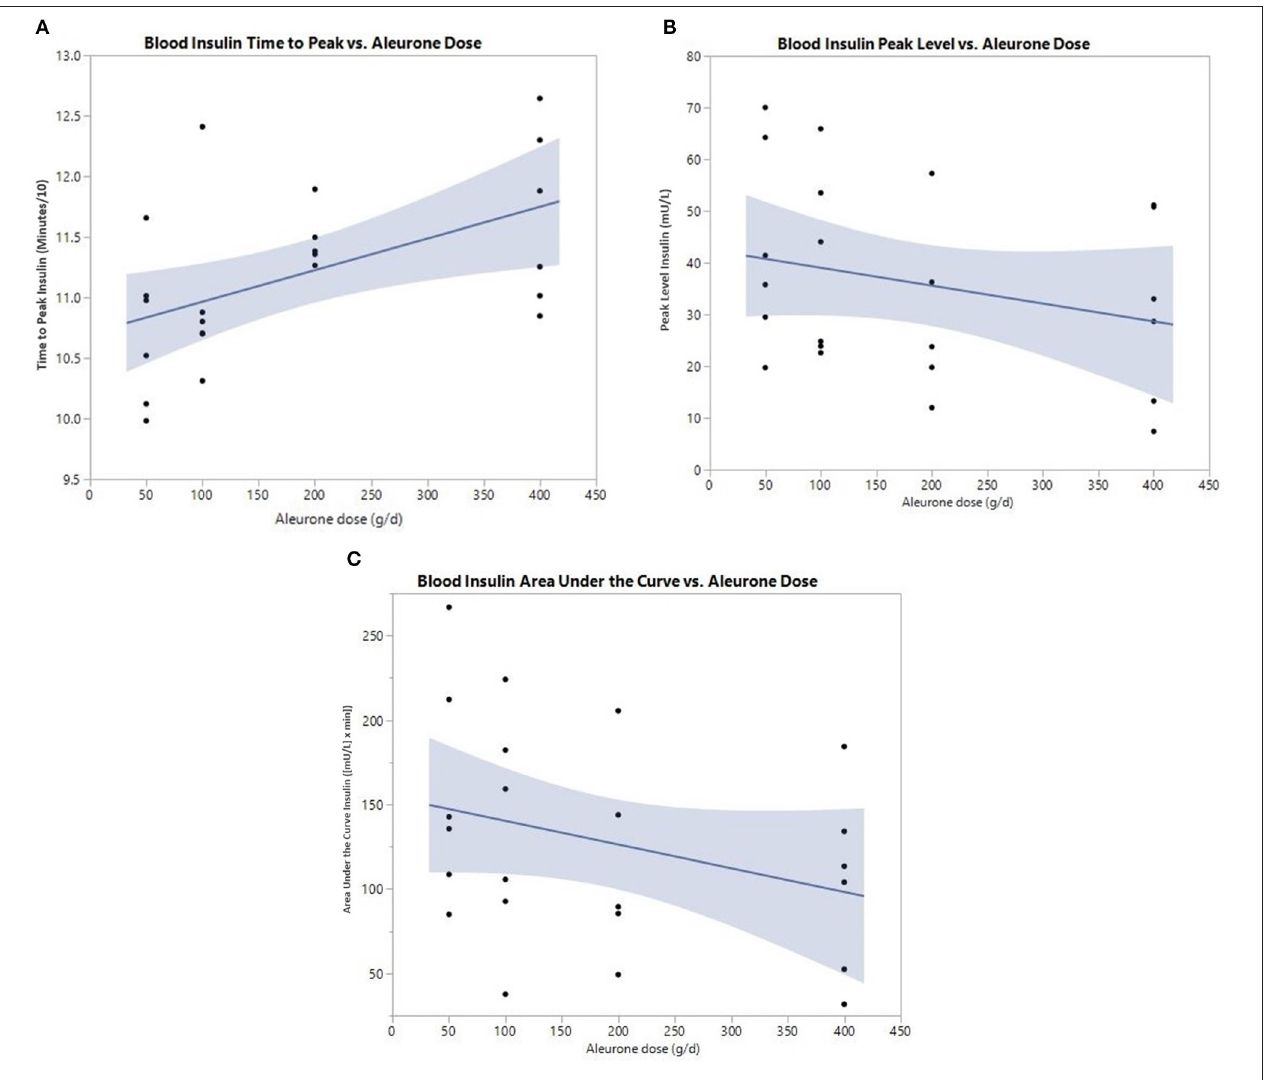
FIGURE 2 | (A) Postprandial time to peak (min/10) of blood insulin after supplementing with either 0, 50, 100, 200, or 400 grams of aleurone. (B) Postprandial peak level of blood insulin (mU/L) after supplementing horses with either 0, 50, 100, 200, or 400g of aleurone. (C) Postprandial blood insulin AUC [(mU/L) × min] after supplementing horses with either 0, 50, 100, 200, or 400g of